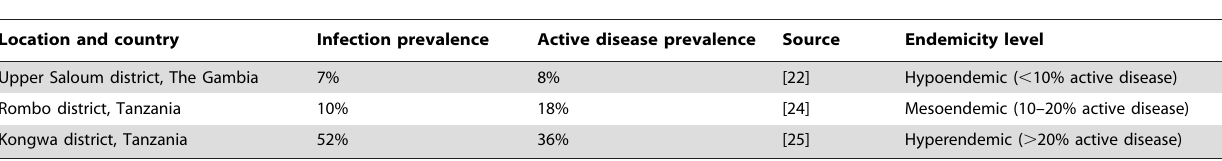
Table 1. Summary of the infection and disease levels for the data-sets used in this study.